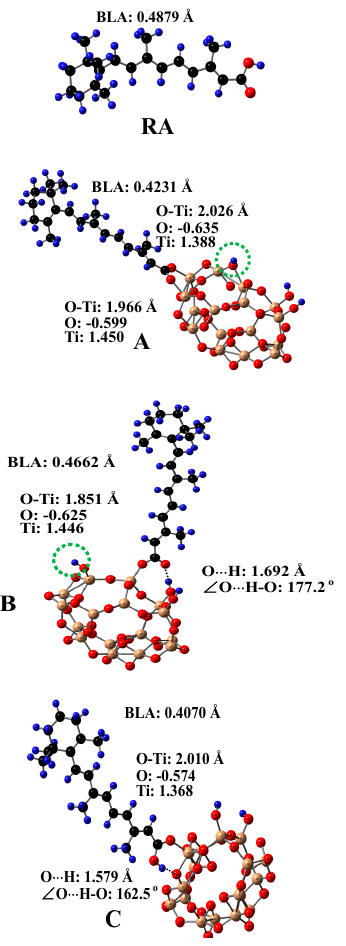
Figure 8. The optimized structures of retinoic acid (RA) and three complexes A, B, C for RA on the surface of a (TiO 2 ) 16 cluster. The bond lengths of O ⋅⋅⋅ H and O-Ti and ∠ O ⋅⋅⋅ H-O for the complexes are shown in the figure. The calculated Mulliken charges on O and Ti for the O-Ti bonds are listed in the figure. The BLA (bond length alternation) value of RA for each complex is marked on the figure. The BLA value is an indication of the degree of conjugation in a molecule. The value decreases as the degree of conjugation increases. For A and B, the carboxylic acid group of RA loses a proton. The green dotted circle indicates the position of the lost proton. H, blue; O, red; C, black; Ti, gold. Adapted from Ref. [99].